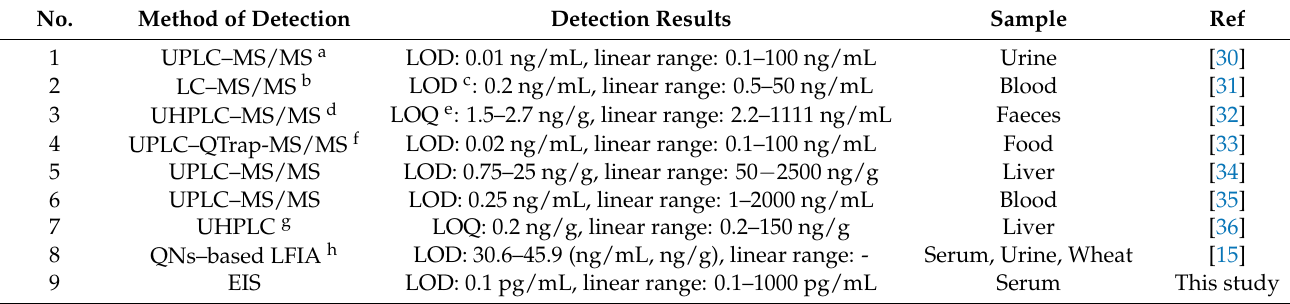
Table 1. Comparison of the detection results of DIF with other published research in the last five